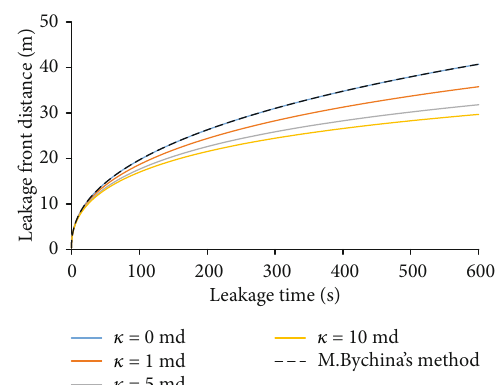
Figure 7: Leakage front distance graph under di ff erent permeability.